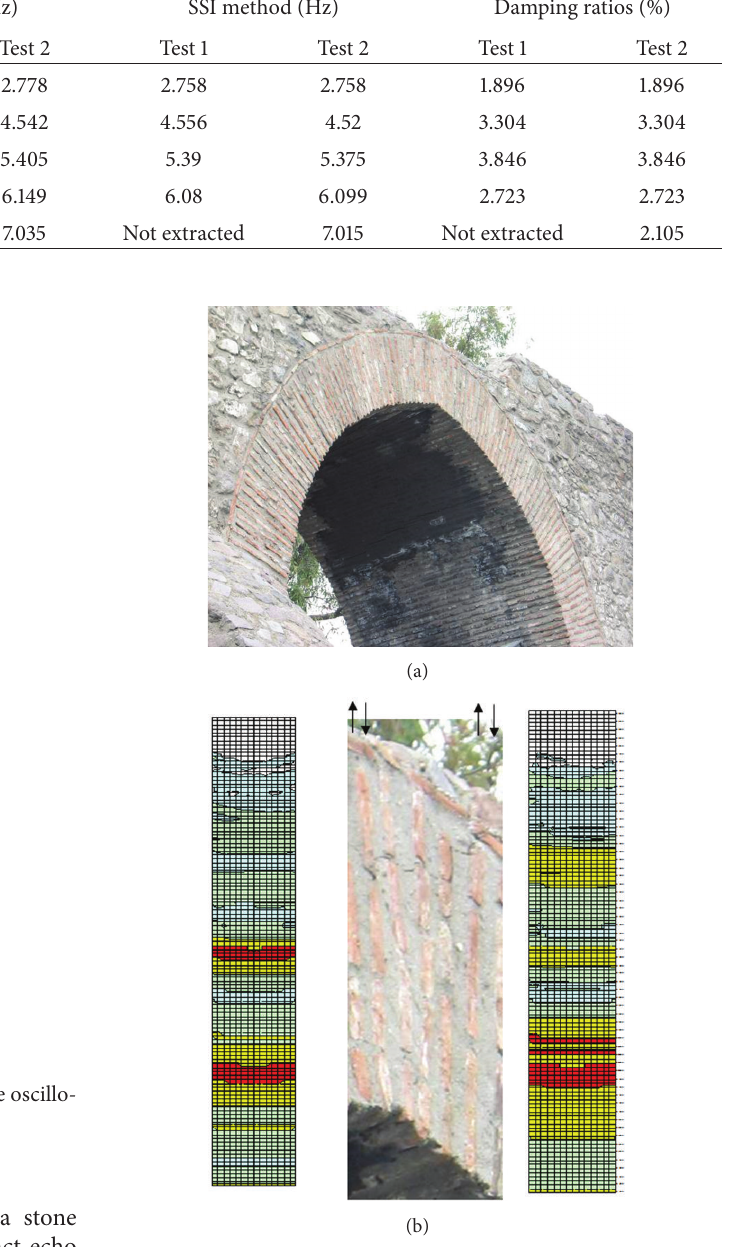
Figure 5: Two impact-echo test results on